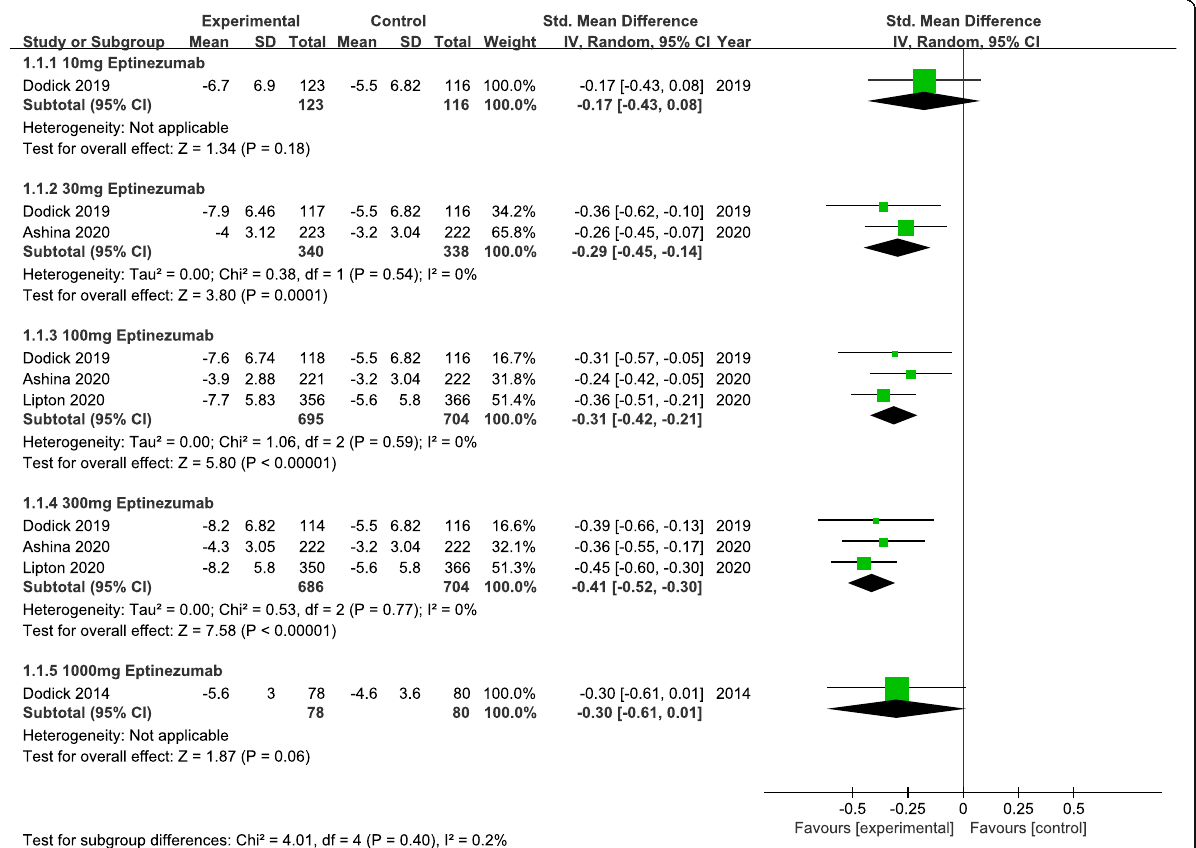
Fig. 2 The pooled standard mean difference (SMD) of monthly migraine days (MMDs) in different treatment doses compared with placebo, the diamond indicates the estimated SMD with 95% confidence interval (CI) for the pooled